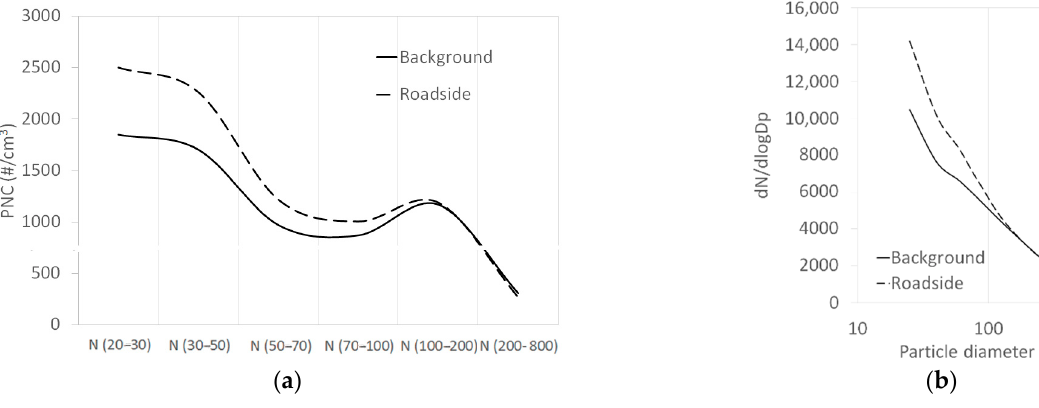
Figure 5. Size-resolved ( a ) and normalized (dN/dlogDp as a function of the median diameter), ( b ) particle-size distribution at both sites over the measurement period.